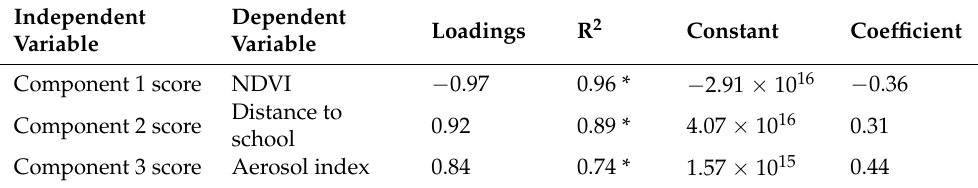
Table 6. Summary of the UQoL regression